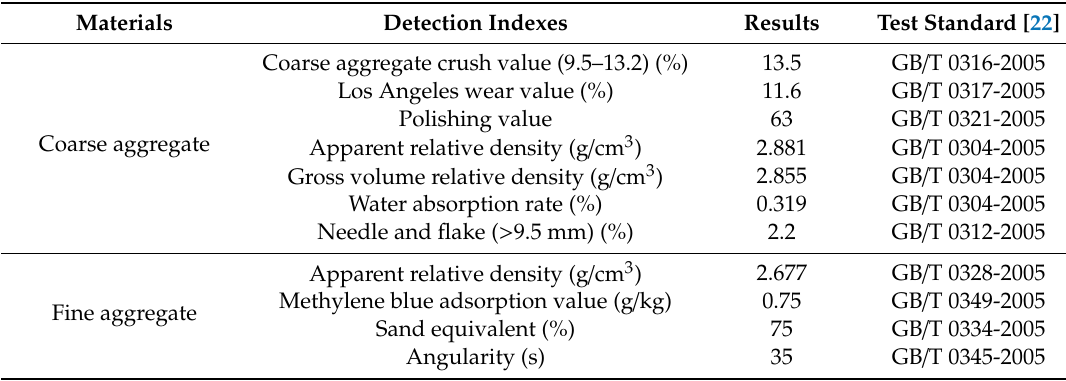
Table 3. Technical indexes of